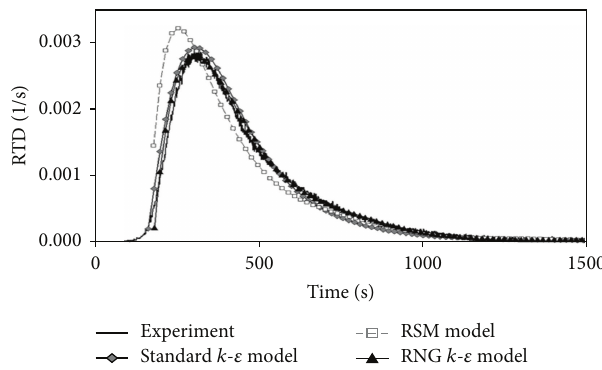
Figure 9: Experimental and simulated RTD functions by Furman and Stegowski 2011